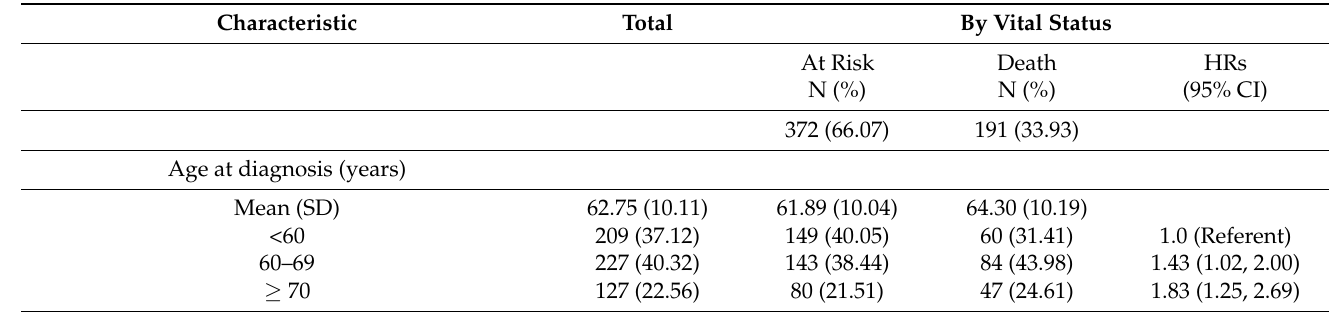
Table 1. Demographics, clinical characteristics, age-adjusted univariate hazard ratios (HRs), and 95% confidence intervals (CIs) for all-cause mortality a , UChicago Multiple Myeloma Epidemiology Study,